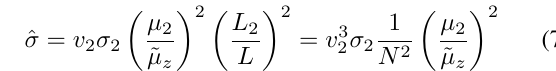
(a) a circular component with square inclusions, (b) a plate composed of ellipsoidal inclusions,